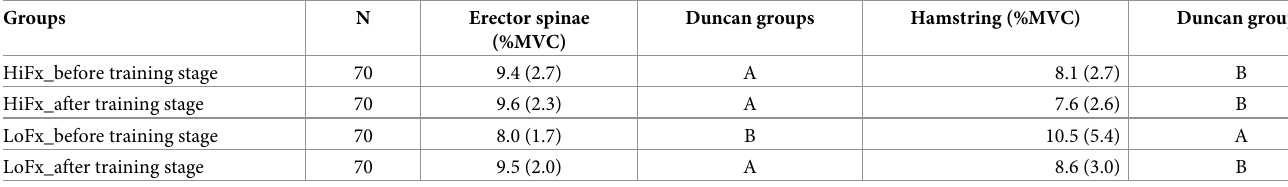
Table 4. Muscle activation of Duncan groups for varying flexibility and training combinations. Groups